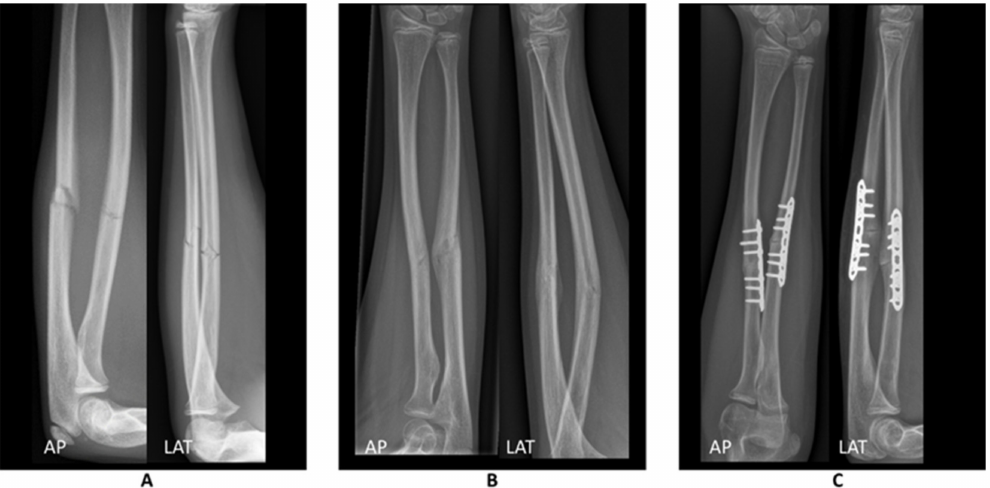
Figure 1. Radiographs of the forearm in anterior posterior (AP) and lateral (LAT) directions ( A ) at initial trauma, ( B ) 3 months after initial trauma where the fracture is consolidated and the arm shows bowing and dorsal angulation, and ( C ) after patient-specific guided